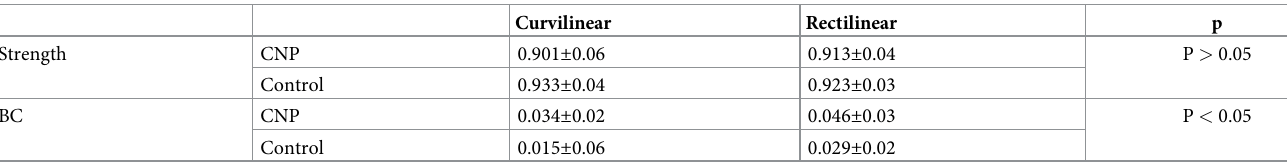
Table 5. Network